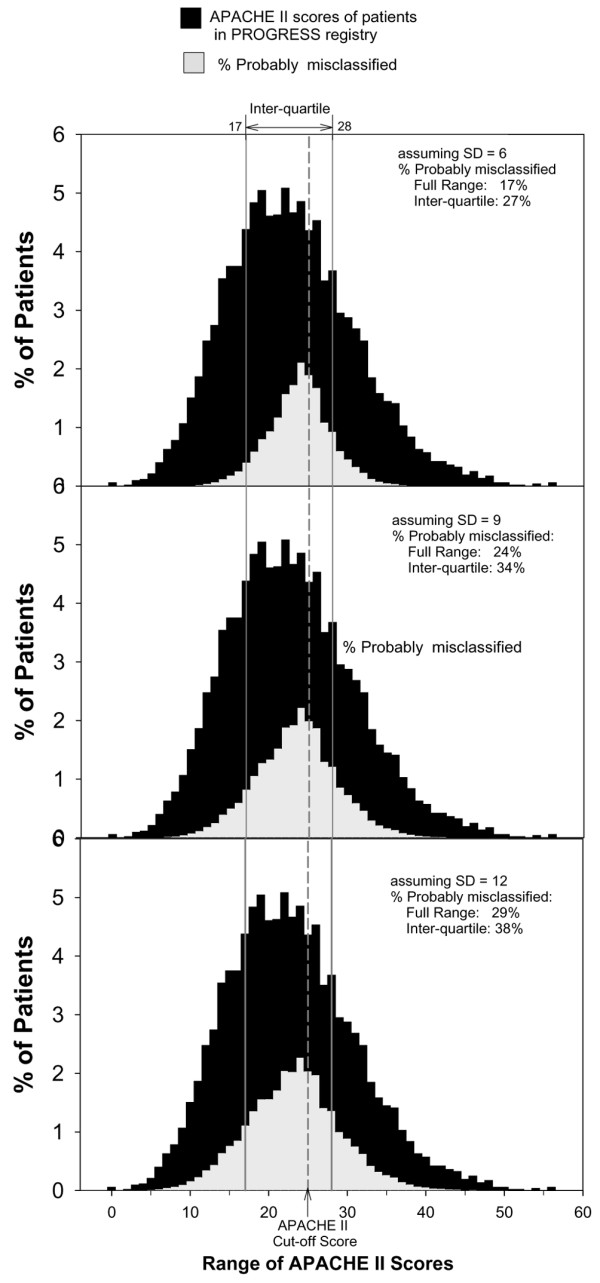
Distribution of reported APACHE II scores in the PROGRESS registry. The darker shading (outer envelope) of these plots represents the observed distribution of APACHE II scores of 5,253 severe sepsis patients in the PROGRESS registry. The lighter shading (inner envelope) is calculated by applying the probability of misclassification for each individual APACHE II score based on assumed standard deviation (SD) of (from top to bottom) 6, 9 and 12 and on an APACHE II cut-off score ≥25.